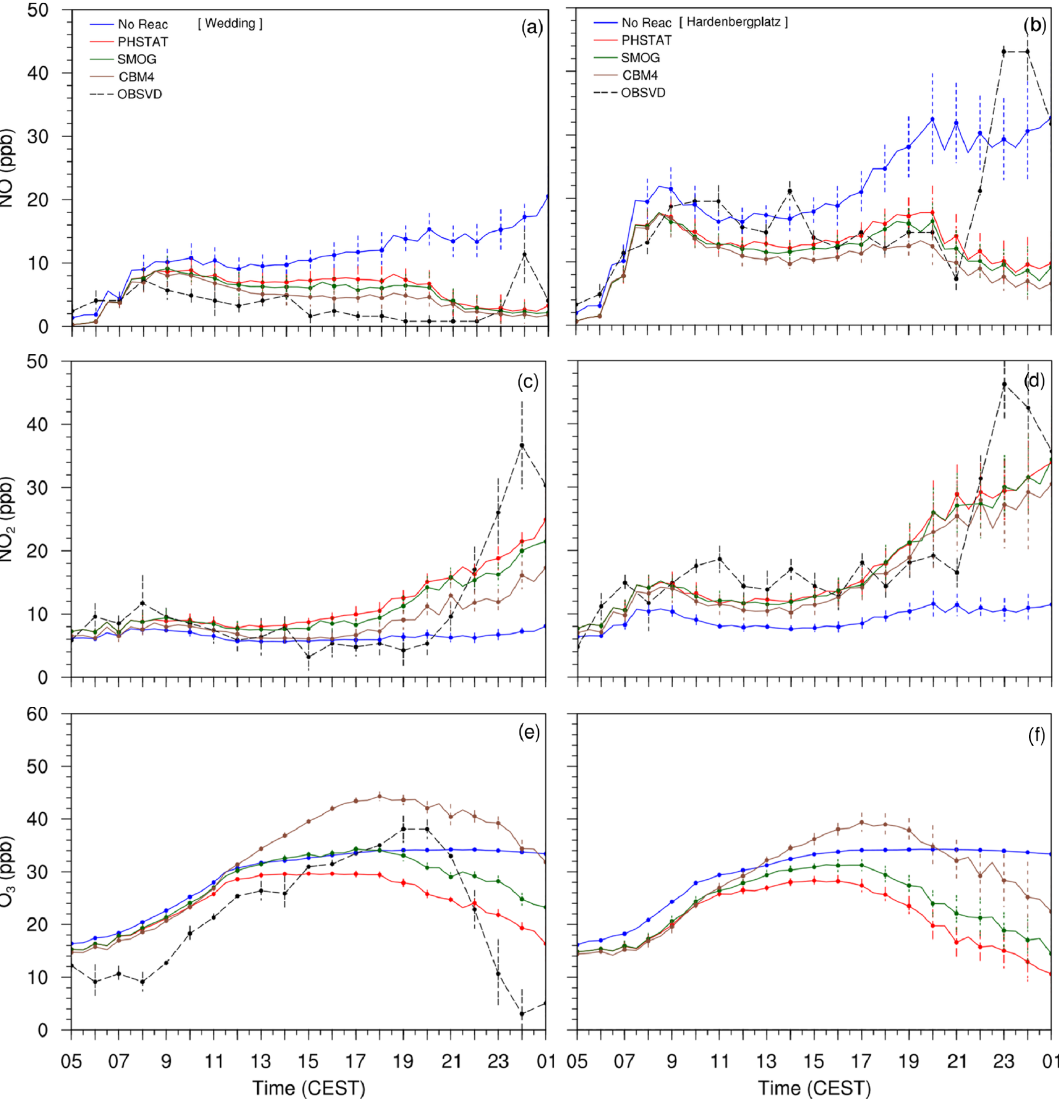
Figure 10. Time series plots of the near-surface NO, NO 2 and O 3 concentrations from four mechanisms (NO-REAC, PHSTAT, SMOG, CBM4) and observations from 05:00CEST (17 July) to 01:00CEST (18 July 2017). The left column (a, c, e) shows time series from Wedding, and the right column (b, d, f) shows time series plots from